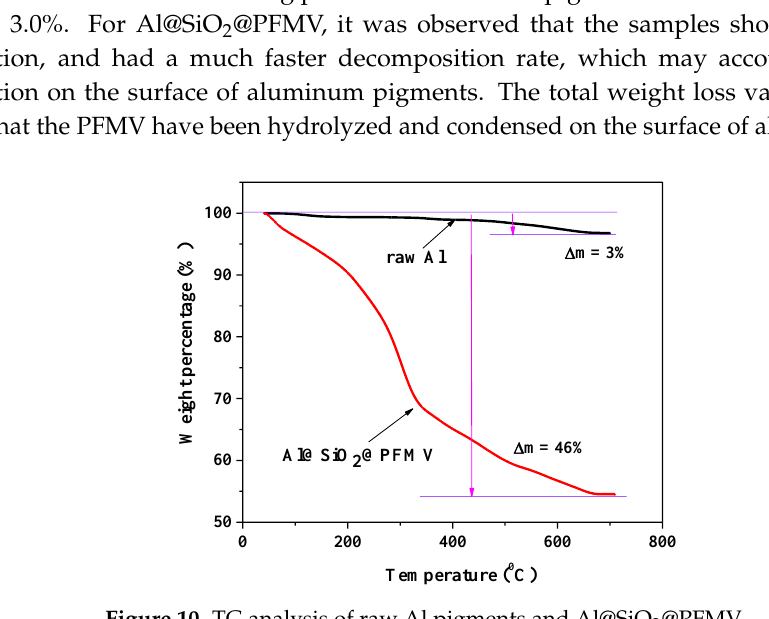
Figure 10. TG analysis of raw Al pigments and Al@SiO 2 @PFMV.